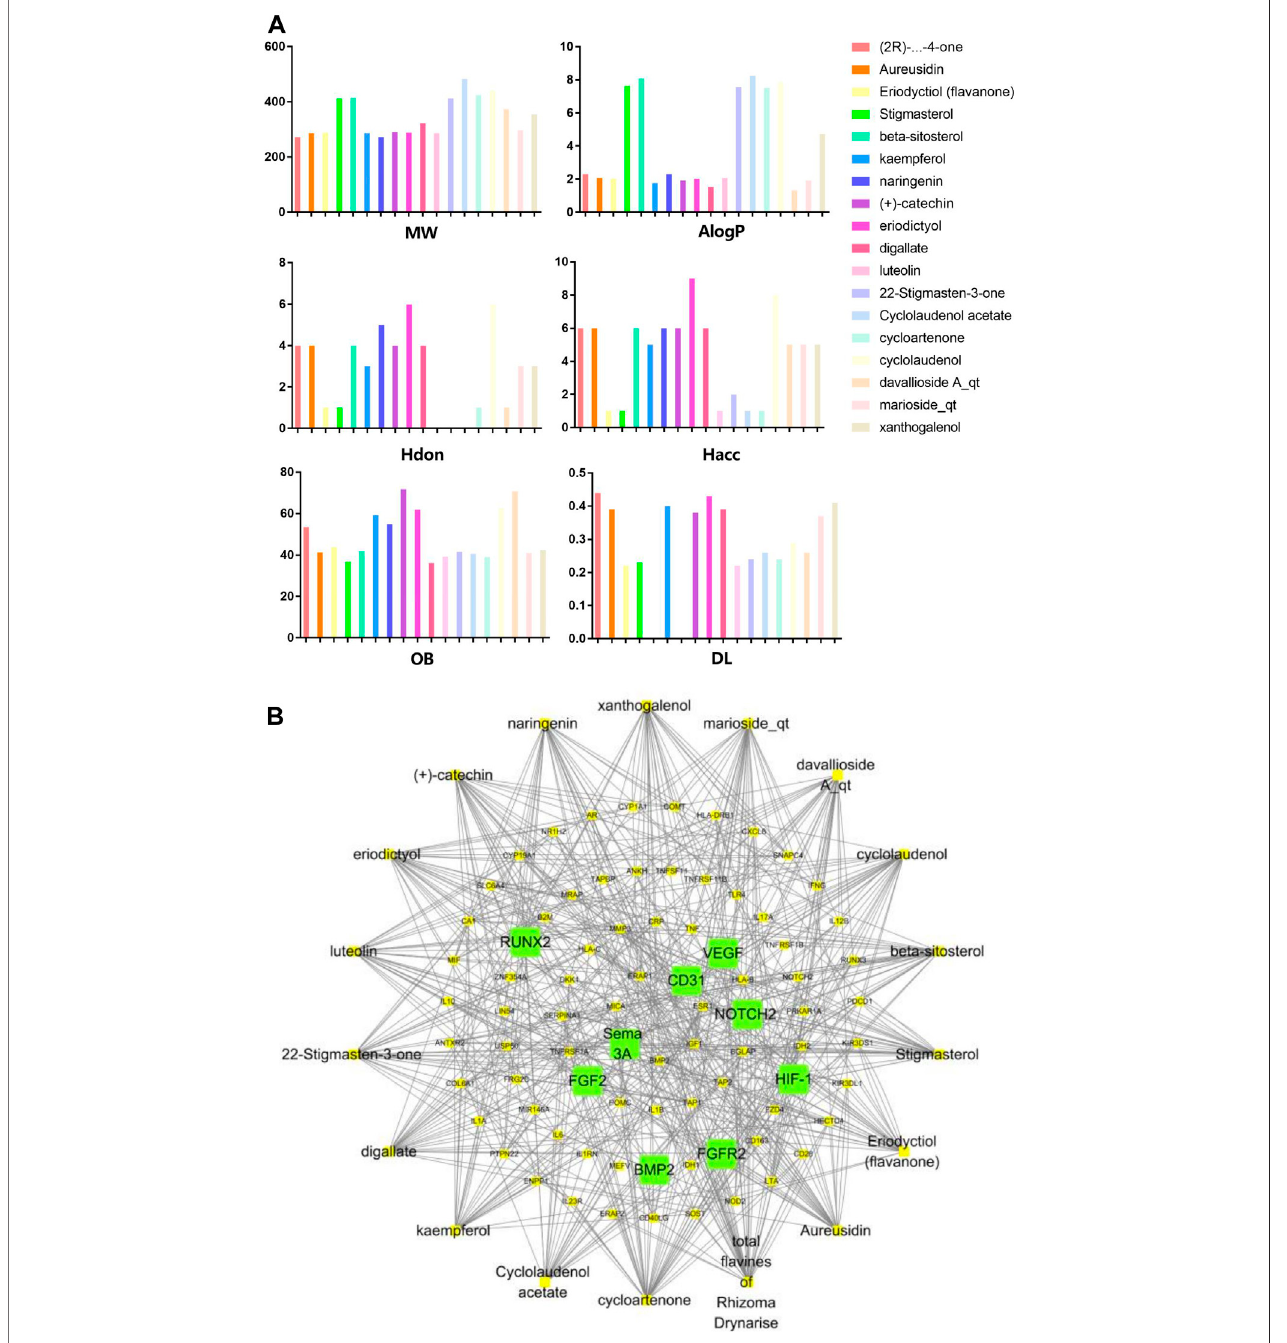
FIGURE1|(A) ThemolecularpropertiesofchemicalcandidatesinRD.The18gatheredchemicalcandidateswerelistedintherightsideofthe fi gure(2R)-...-4-one is the contraction of (2R)-5, 7-dihydroxy-2-(4-hydroxyphenyl) chroman-4-one; (B) chemical candidates-potential therapeutic targets network of RD acting on osteogensis. In the network, orange points represent the chemical candidates of RD, yellow points represent the therapeutic targets with weak linkage to osteogenesis and the huge green points stood for the core targets, being de fi ned based on existing studies and data.